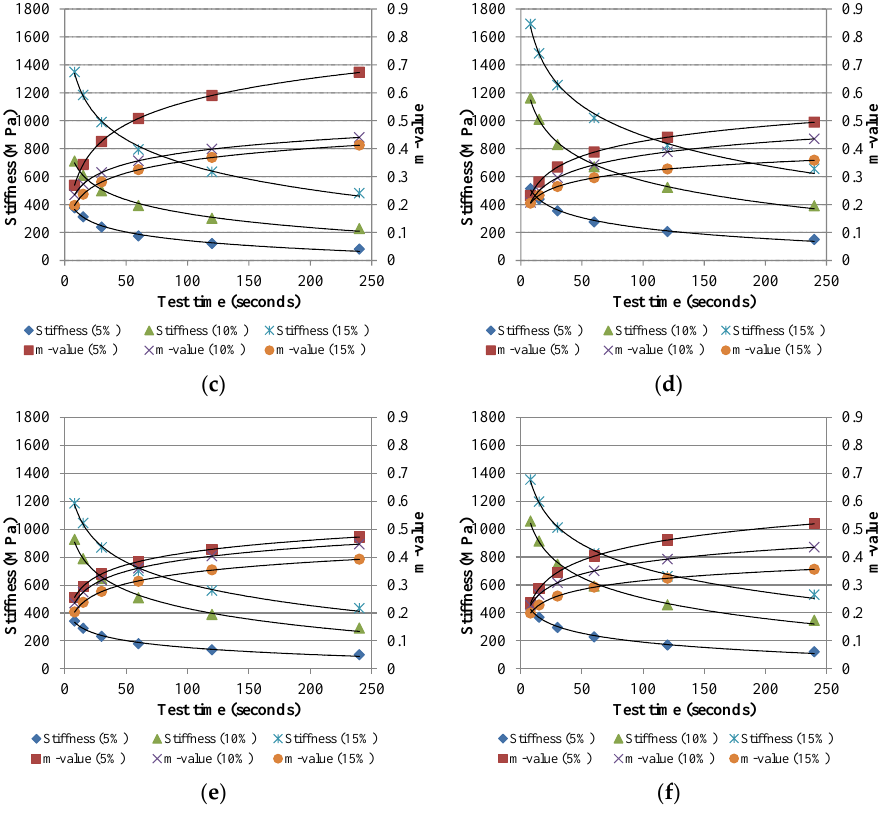
Figure 7. Stiffness and m-values of RAP sources A–F modified with PAV binder PG 58-22, ( a – f ) RAP sources A–F.